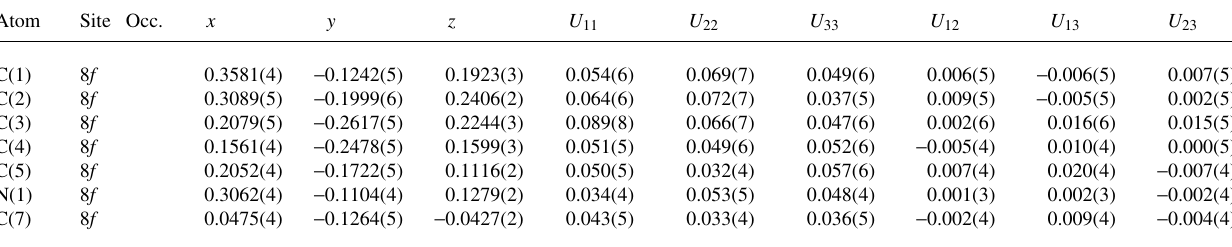
Table 3. Atomic coordinates and displacement parameters (in Å 2 )